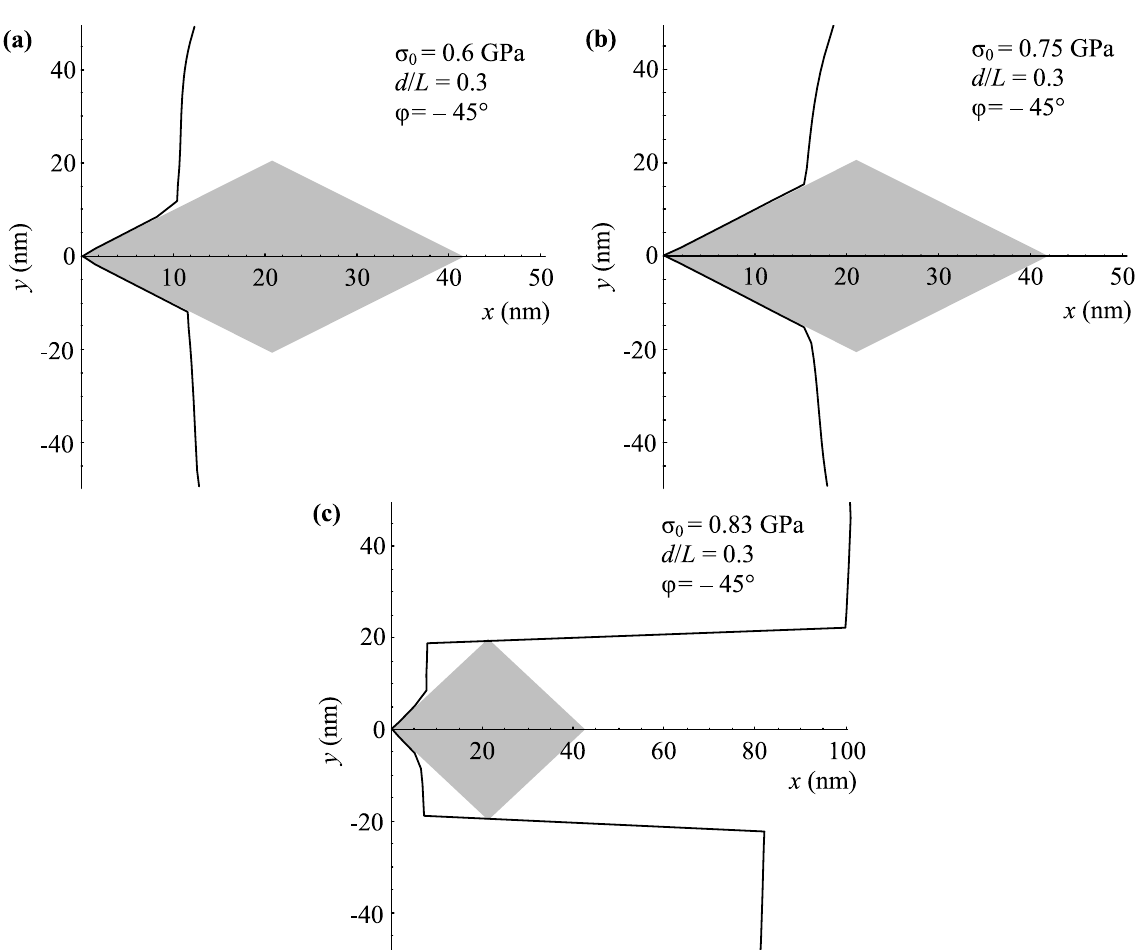
Fig. 3. Geometry of a migrating grain boundary that bends around a nanoinclusion at various values of applied stress calculated for angle  = -45 ° . (a), (b) Equilibrium profiles of a migrating grain boundary. (c) Nonequilibrium profile of a migrating grain